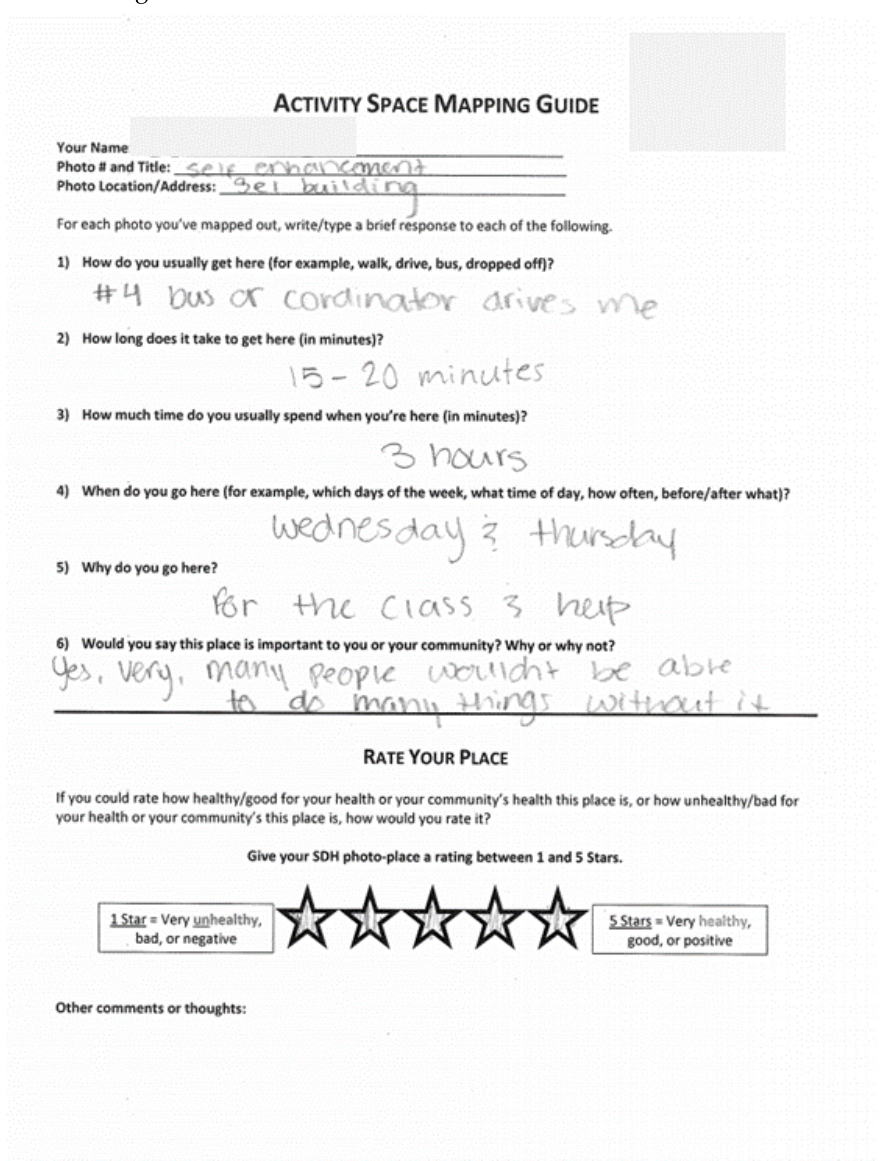
Figure 2. Example of a completed Activity Space Mapping